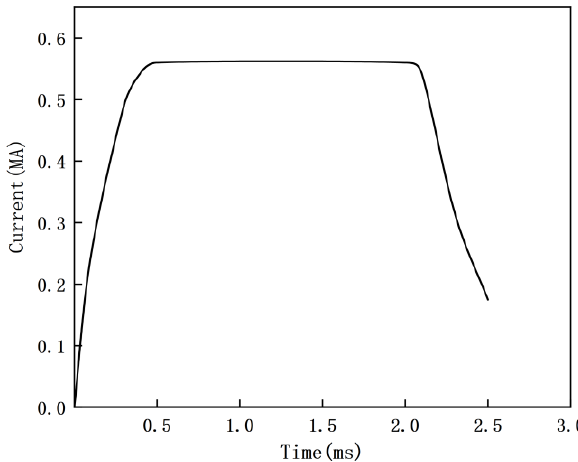
Figure 2. Waveform diagram of trapezoidal excitation current.